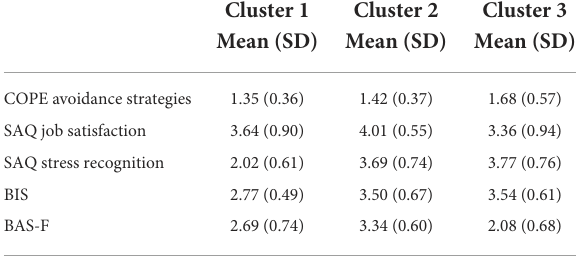
TABLE 5 Descriptive statistics for professionals from the three clusters on study